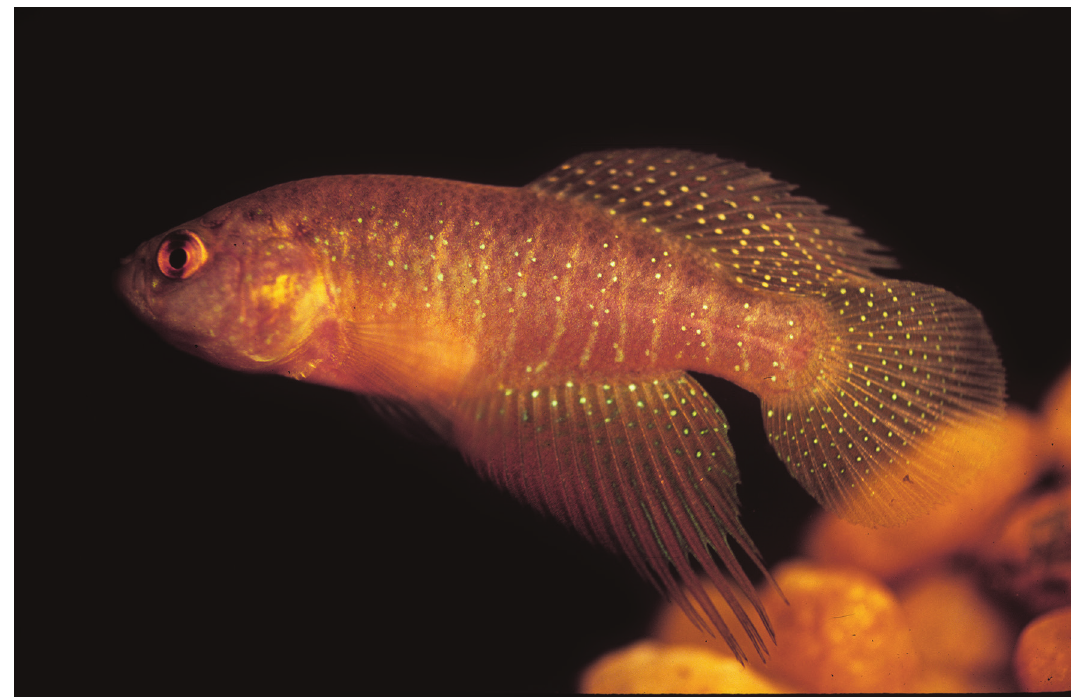
Figure 1. Cynolebias elegans sp. n., live holotype, UFRJ 9431, male, 36.1 mm SL. Photograph by W.J.E.M. Costa.